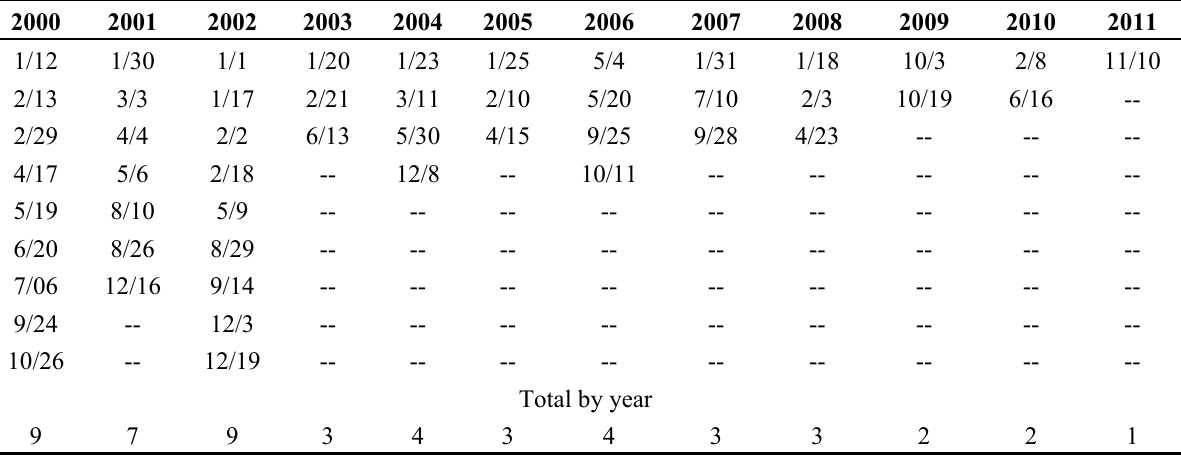
Table 1. Month and day of analyzed Landsat 5 (WRS-2 Path 15/Row 42) scenes within years along with total scenes per year (bottom